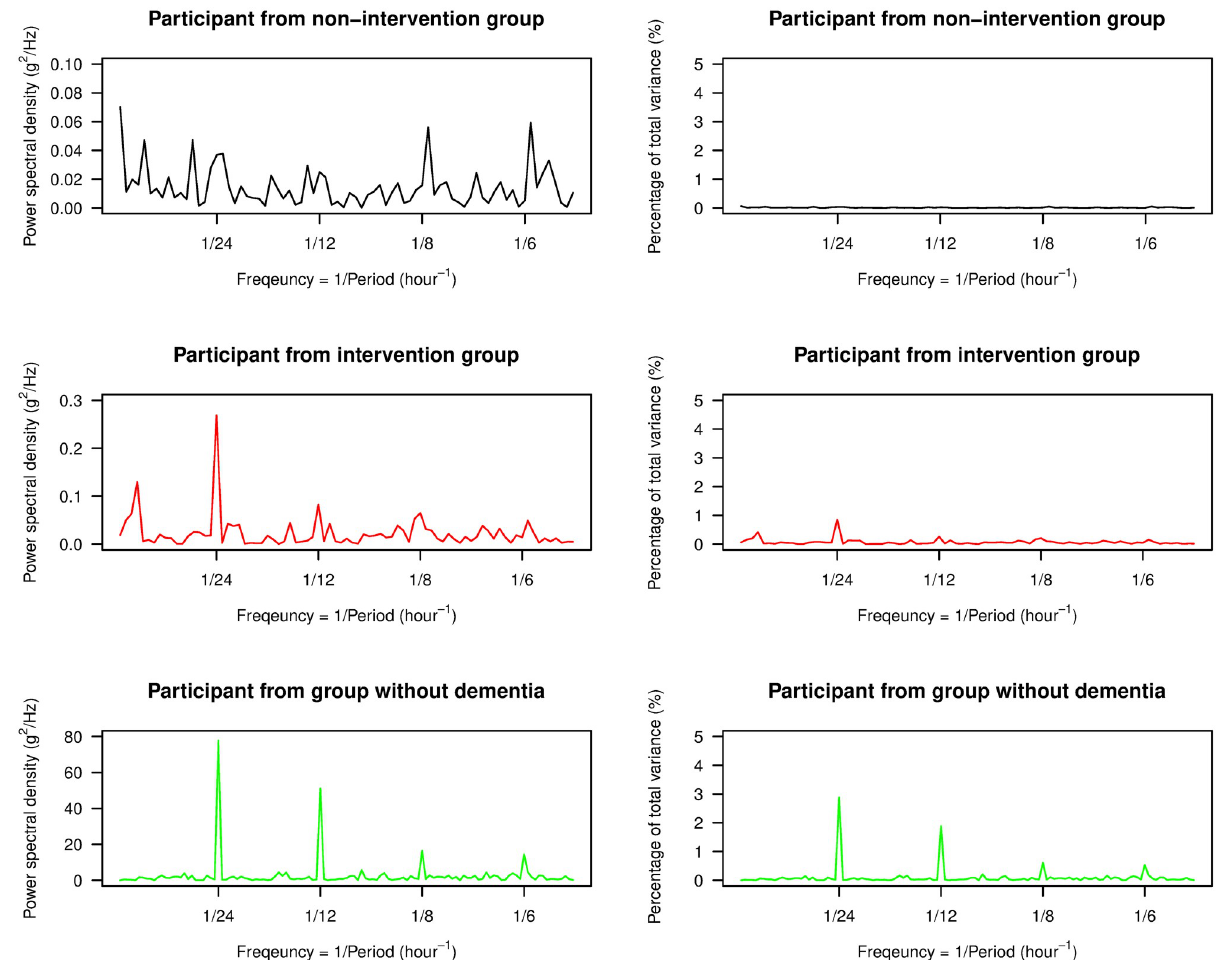
Fig 9. Periodograms. The left panel displays the plots of the power spectral density estimated by the periodogram for three participants, one from each of the non-intervention group, the intervention group, and the group of individuals without dementia. The right panel displays the plots of the percentage of the total variance captured at each frequency. The range of frequencies for each plot in both panels includes all four harmonic frequencies used in our